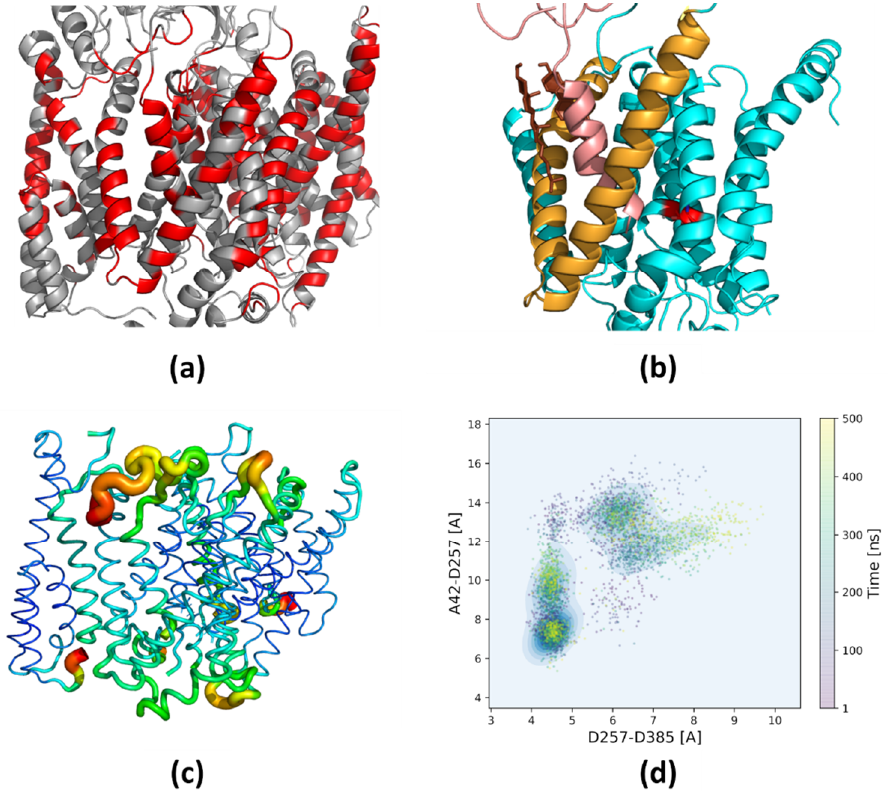
Figure 3. An illustration of the most important findings described in the paper. ( a ) Detailed map of the cholesterol binding sites; ( b ) repositioning of the substrate by its direct contact with cholesterol, preventing the bending of PS-1 helix; ( c ) differences in flexibility of the substrates in the binding site of PS-1, especially at a high level of cholesterol; ( d ) differences between substrates in terms of the compacting of the active site.